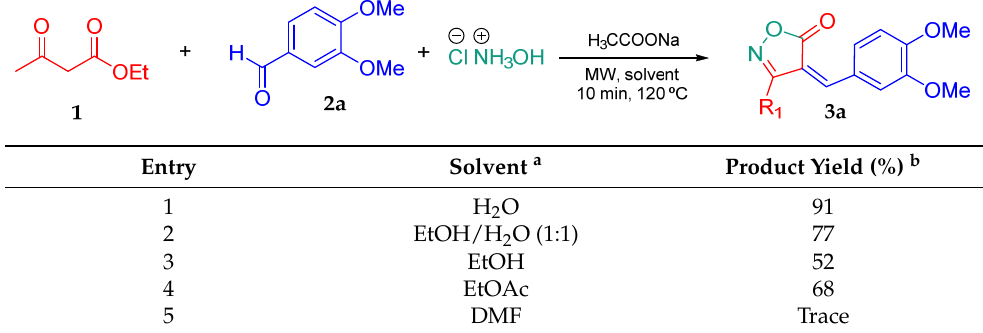
Table 1. Solvent evaluation under microwave heating.